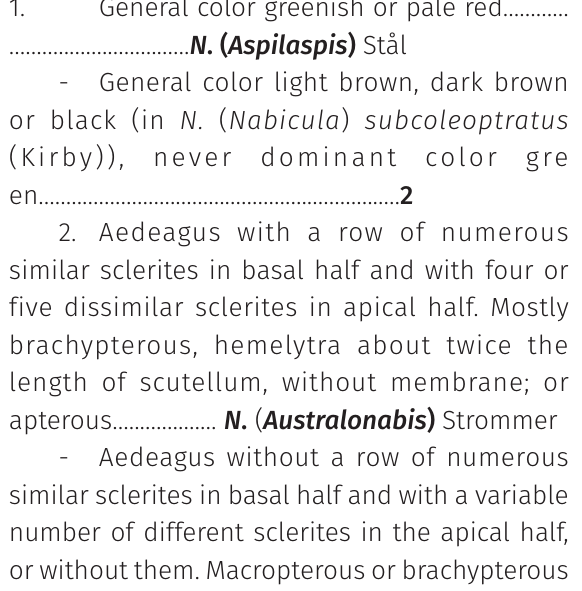
Key to the subgenera of Nabis from the world 1.